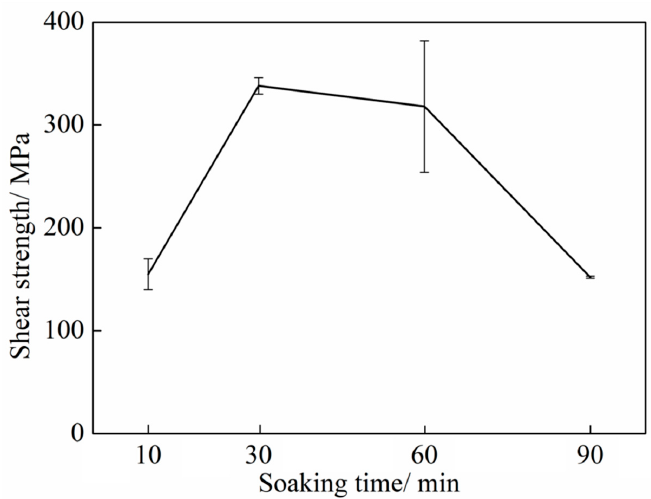
Figure 11. Shear strength of the DD98M-DD98M joints brazed at 1060 ° C for different soaking time.